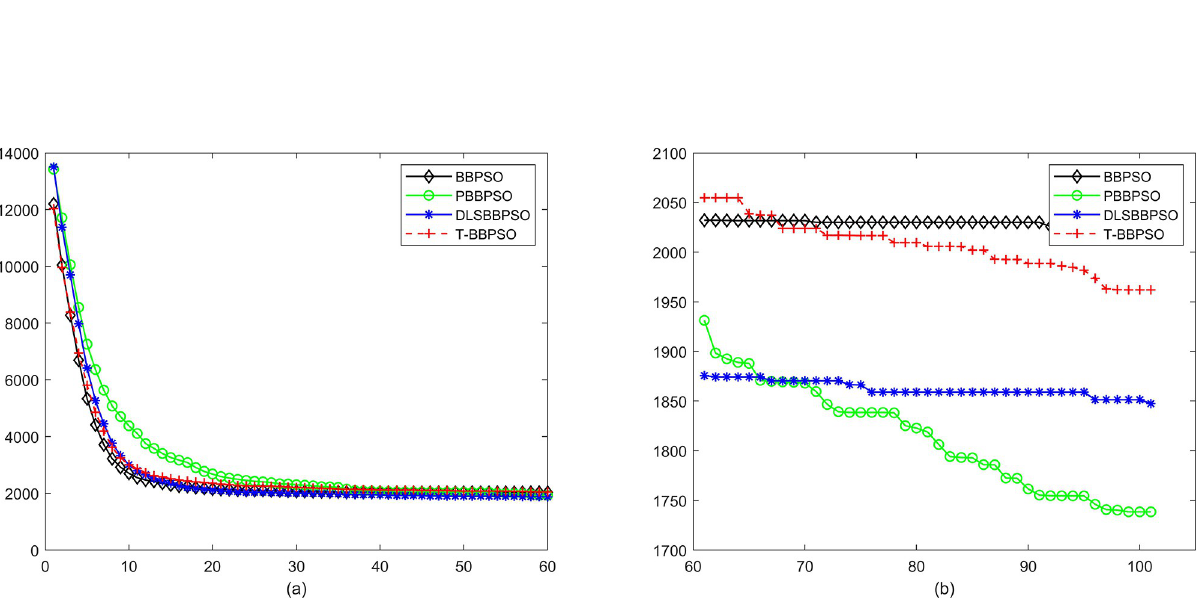
Fig 11. Comparison of convergence speed between BBPSO, PBBPSO, DLS-BBPSO and TBBPSO, f 9 , (a) iteration 0–6000, (b) iteration 6000–10000 the unit is 100 iteration.